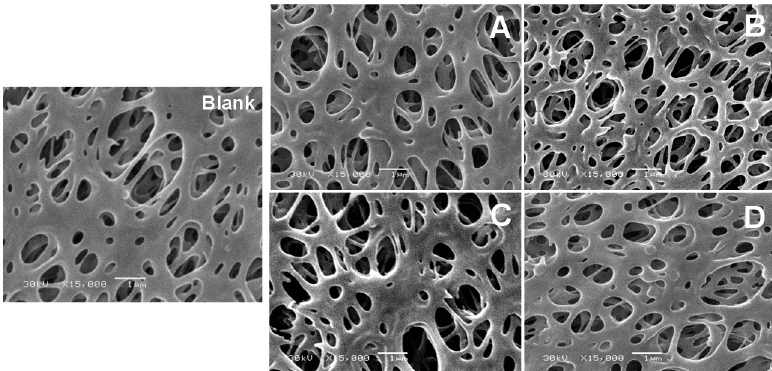
Figure 8. The scanning electron microscope (SEM) images for the blank poly(ethersulfone) (PES) membrane, and the modified PES membranes: ( A , B ) modified PES membranes using 5 and 15 mM modifier (2-AP), respectively at 25 °C; and ( C , D ) modified PES membranes using 5 and 15 mM 2-AP, respectively at 40 °C. Common reaction condition is pH 5.5 (0.1 M sodium acetate buffer), 0.5 U·mL − 1 enzyme (laccase), and 120 min modification time. Magnification is 15,000×; and scale bar is 1 µm.